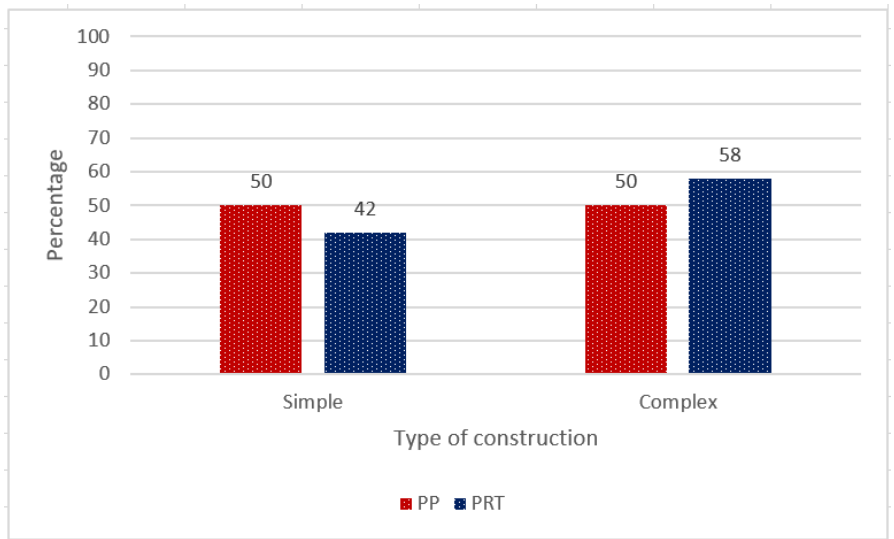
Figure 6 . Distribution of Present Perfect and Preterite in simple and complex constructions